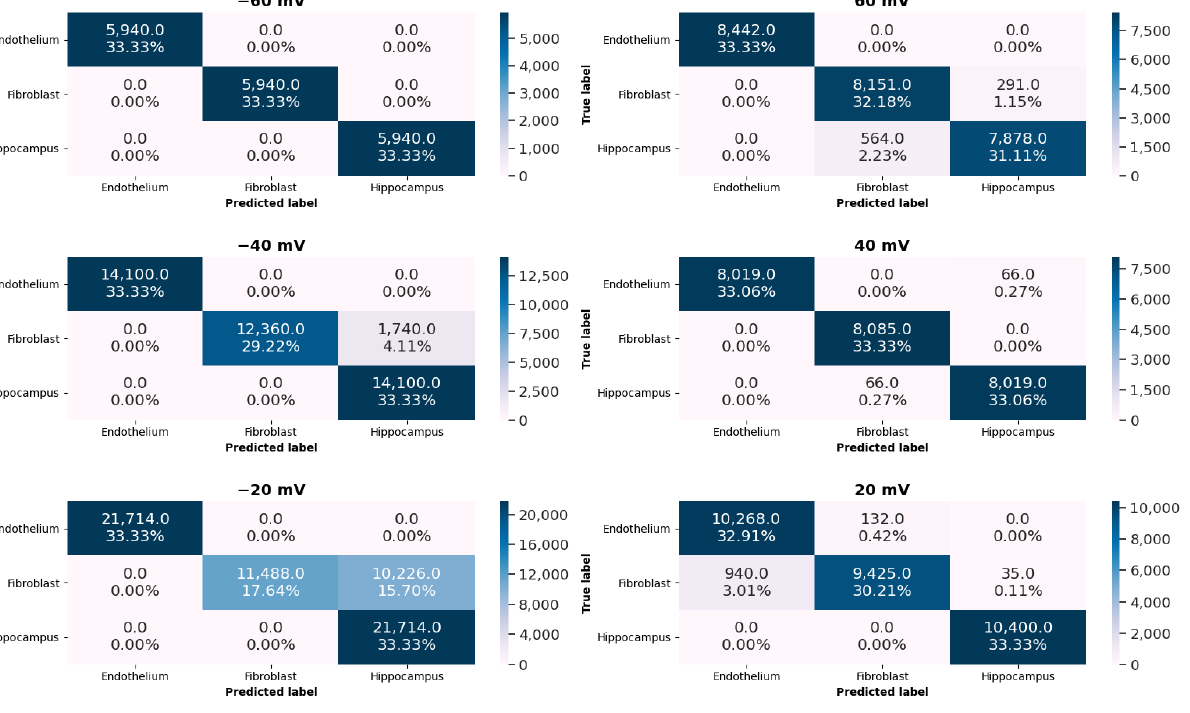
Figure 3. The set of confusion matrices for different pipette potentials. The values given in each block of the confusion matrices indicate the number and percentage of samples classified in a given category. Please note that the overall number of samples for each potential U m is different, but it is equally distributed among three cell